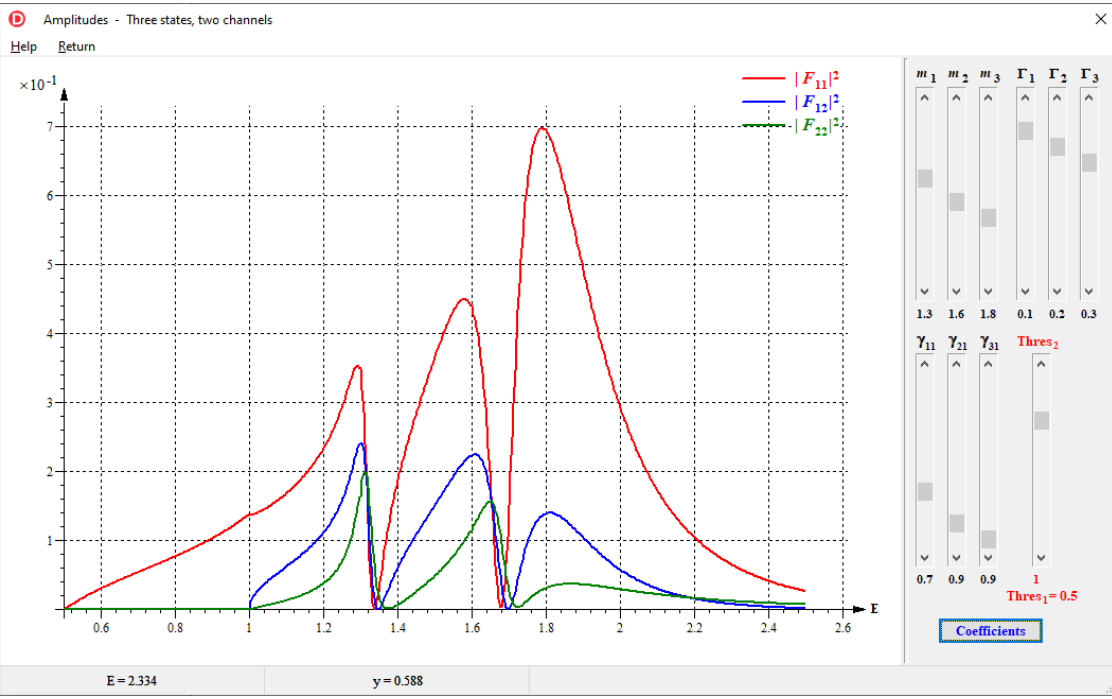
Figure A2. K-matrix scattering amplitudes. The parameters in the screenshot in Figure A2 are: